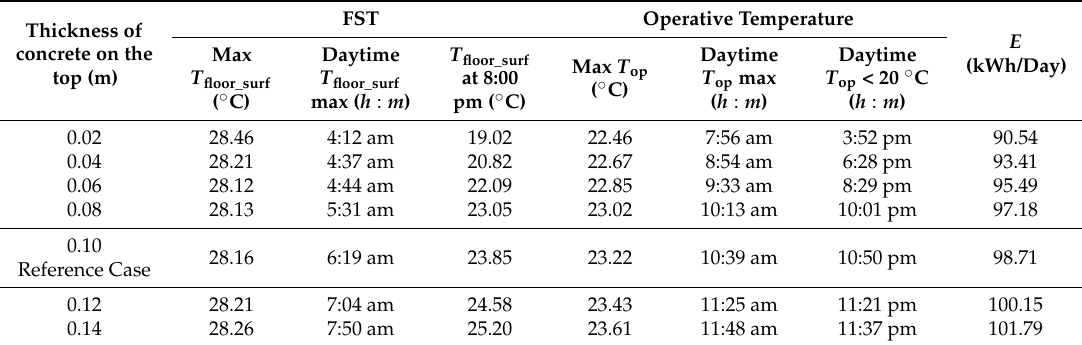
Table 6. Results of the parametric study: Impact of the top layer concrete